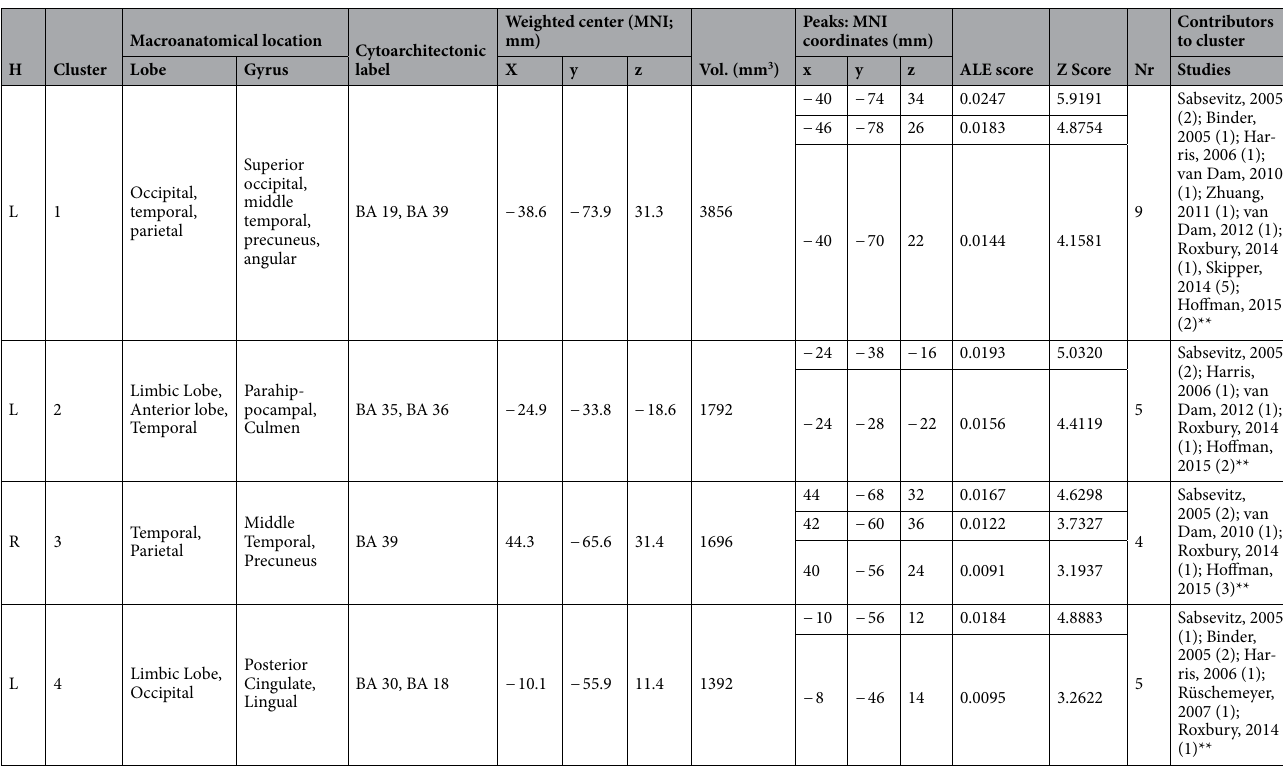
Table 5. Concrete > abstract words—semantic and lexical tasks only- clusters. Included 114 stereotactic activation loci from 16 studies, 273 participants, chosen min. cluster size 656 mm 3 . All the values and